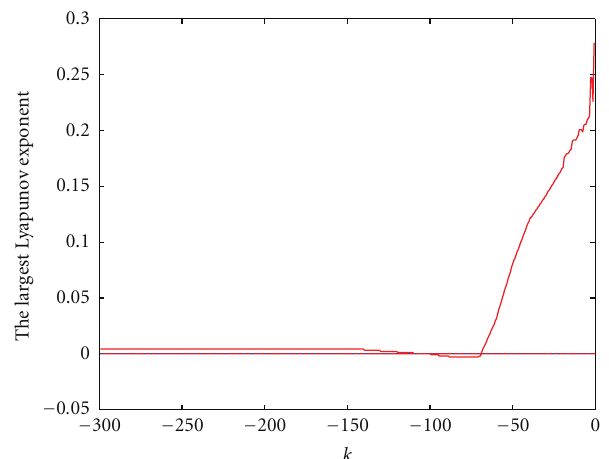
Figure 6: The relationship of the largest Lyapunov exponent (LLE) and k under m = 112 .